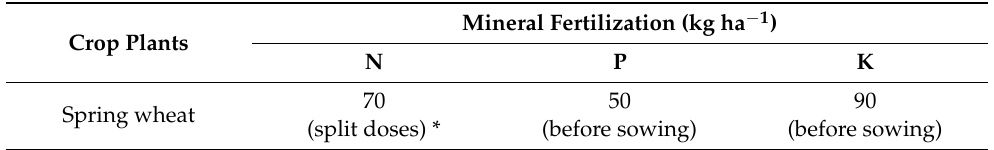
Table 2. Spring wheat fertilization used in a conventional